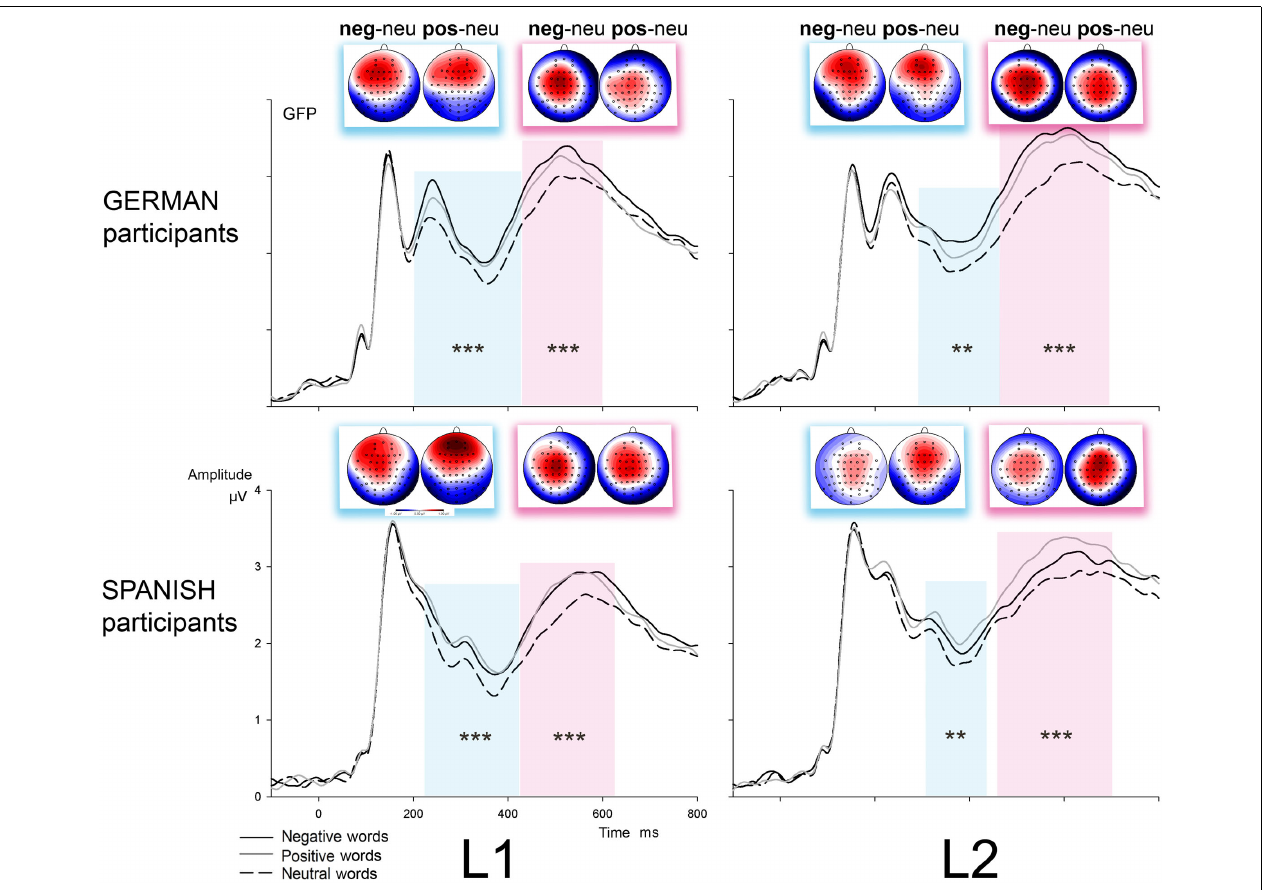
FIGURE 3 | Global field power (GFP) for ERPs of negative, positive, and neutralWords in L1 or L2 for 40 German and 26 Spanish Participants.